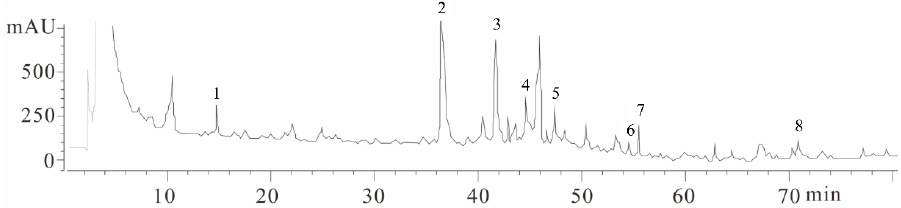
= 10128 x − 11134 ( r 2 = 0.9997). The high correlation coefficients of the calibration curves of each Figure 1. The HPLC fingerprint analysis of the extract from the herbal medicinal compositus prescribed and its main components. The compounds were: Salvianic acid A sodium (1), Salvianolic acid (2), Quercetin-7- O -beta-glucoside (3), Rutin (4), Isorhamnetin-3- O -beta-glucoside (5), Luteolin (6), Epimedium glucoside (7), and Tanshinone 2A (8). 2.2. EBR-84 Retarded the RGC Loss of the NMDA-Treated Rats